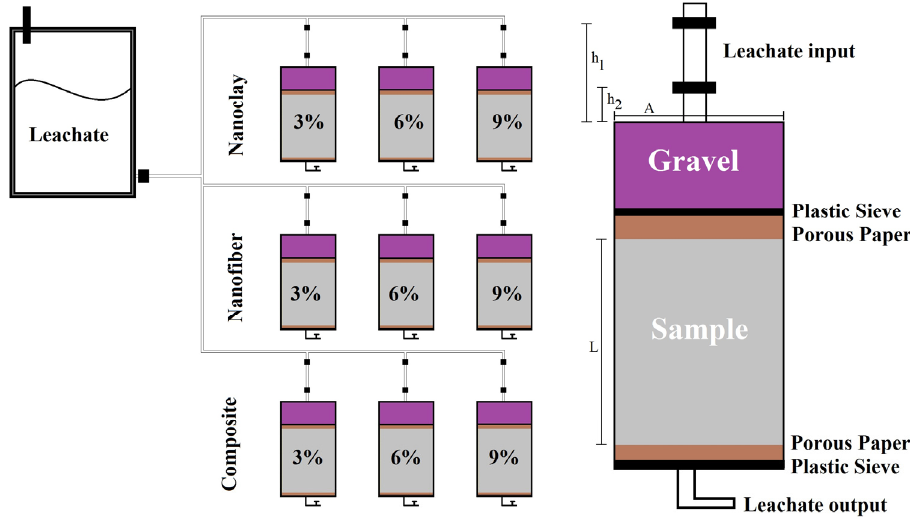
Figure 4. A Scheme of the permeability tests.